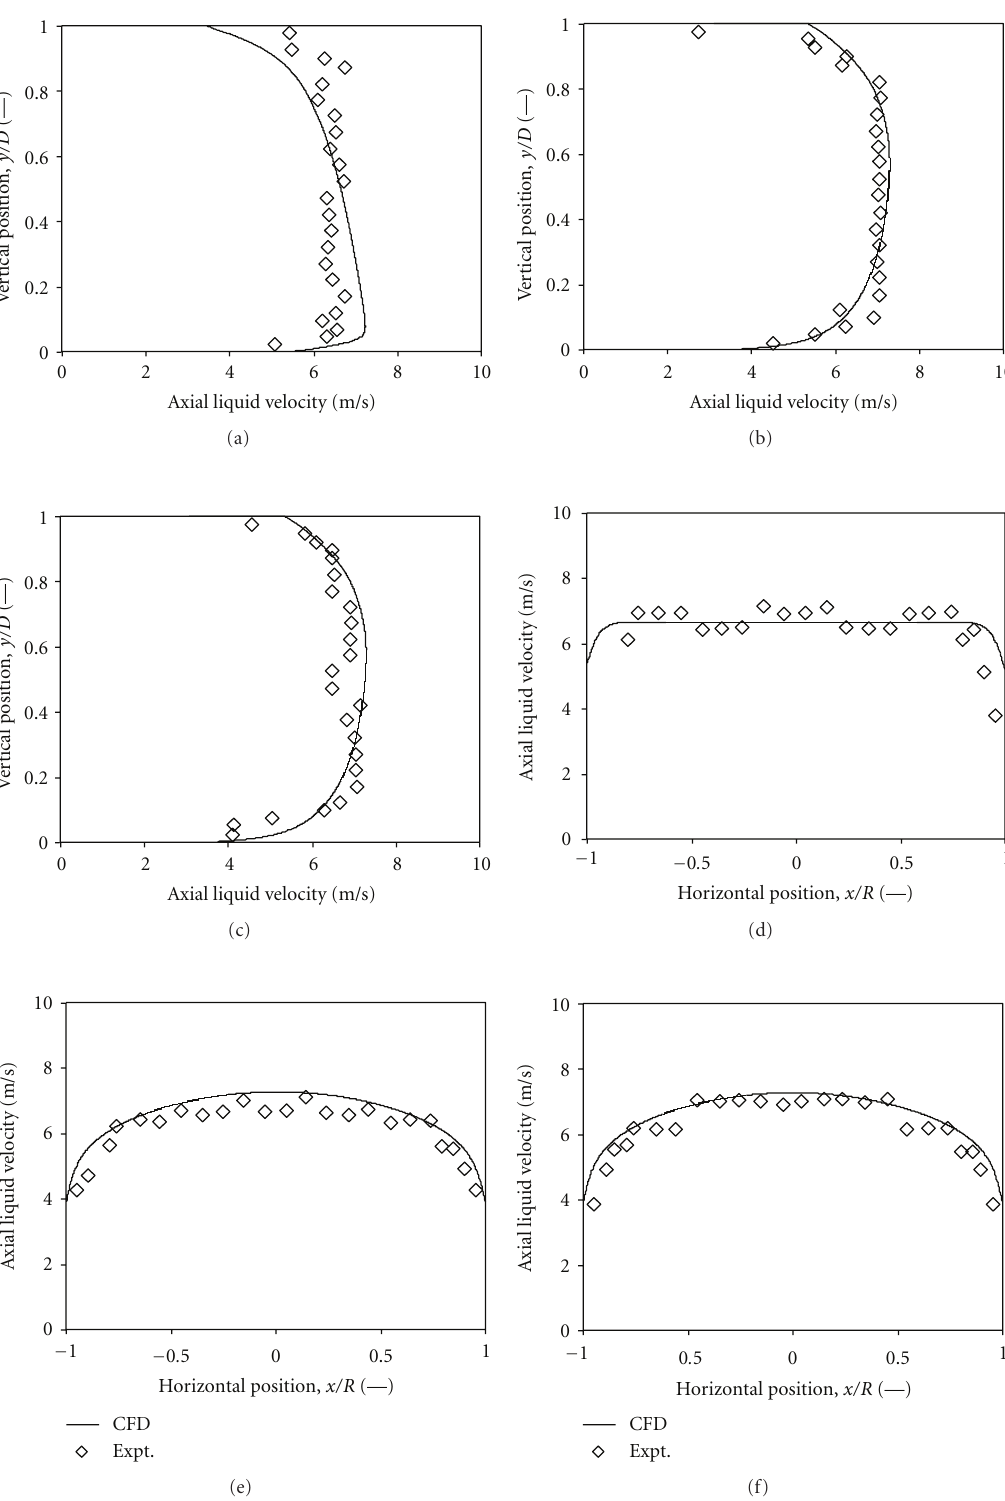
Figure 14: Liquid velocity development in axial direction for superficial gas velocity is 1.21 m/s, superficial liquid velocity is 4.67m/s, and average volume fraction is 0.205. At vertical position, (a) L/D = 25; (b) L/D = 148; (c) L/D = 253, at horizontal position, (d) L/D = 25; (e) L/D = 148; (f) L/D =